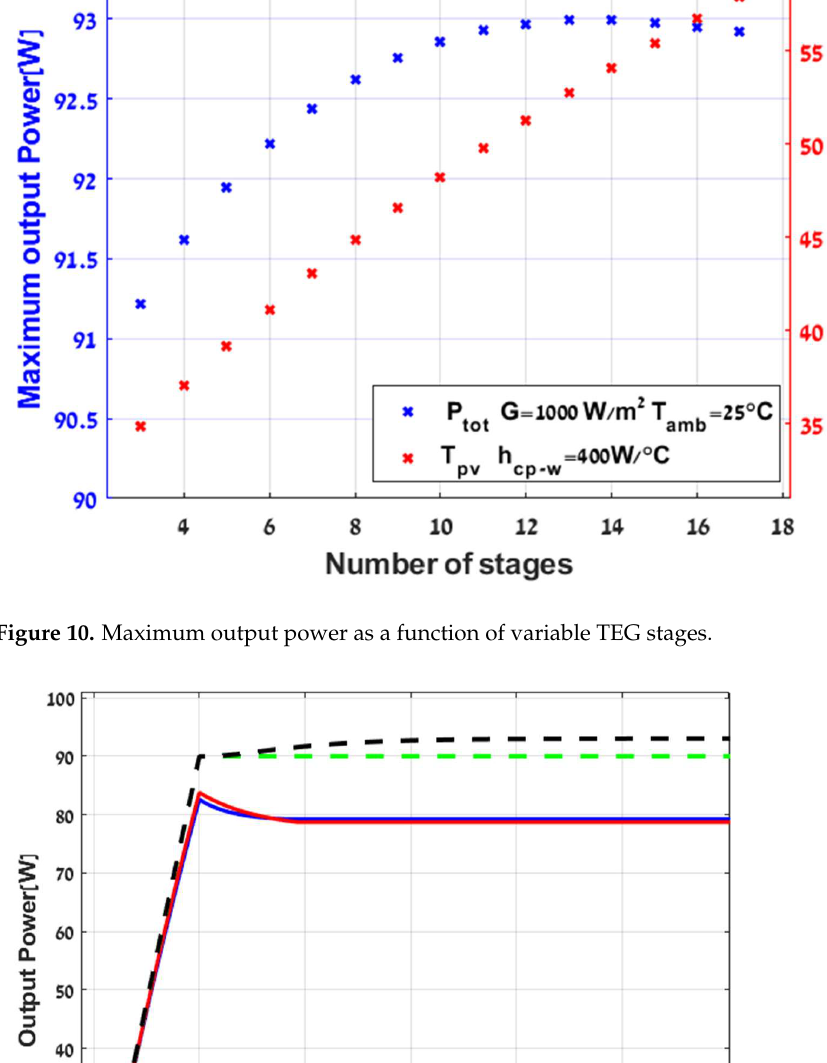
Figure 12. Configuration of PV stand-alone (blue, continuous line), PVTEG without cooling (red, continuous line), PVTEG (green dashed line), and PV Multistage TEG (black dashed line). 5. Conclusion A new multi-stage TEG and amorphous silicon model was developed. The TEGs were installed between a PV and a cold plate. This configuration generated more addi- tional electric power than a conventional stand-alone PV and single PVTEG and increased efficacy. In this study, amorphous silicon (a-Si) solar cells were modeled and simulated. Typically, a-Si holds a low-efficiency temperature coefficient compared to other